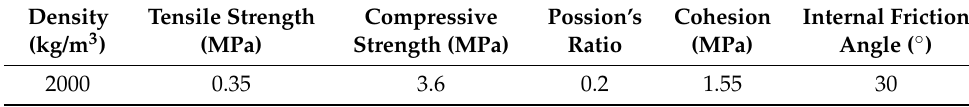
Table 2. Physical and mechanical calculation parameters of filling body.